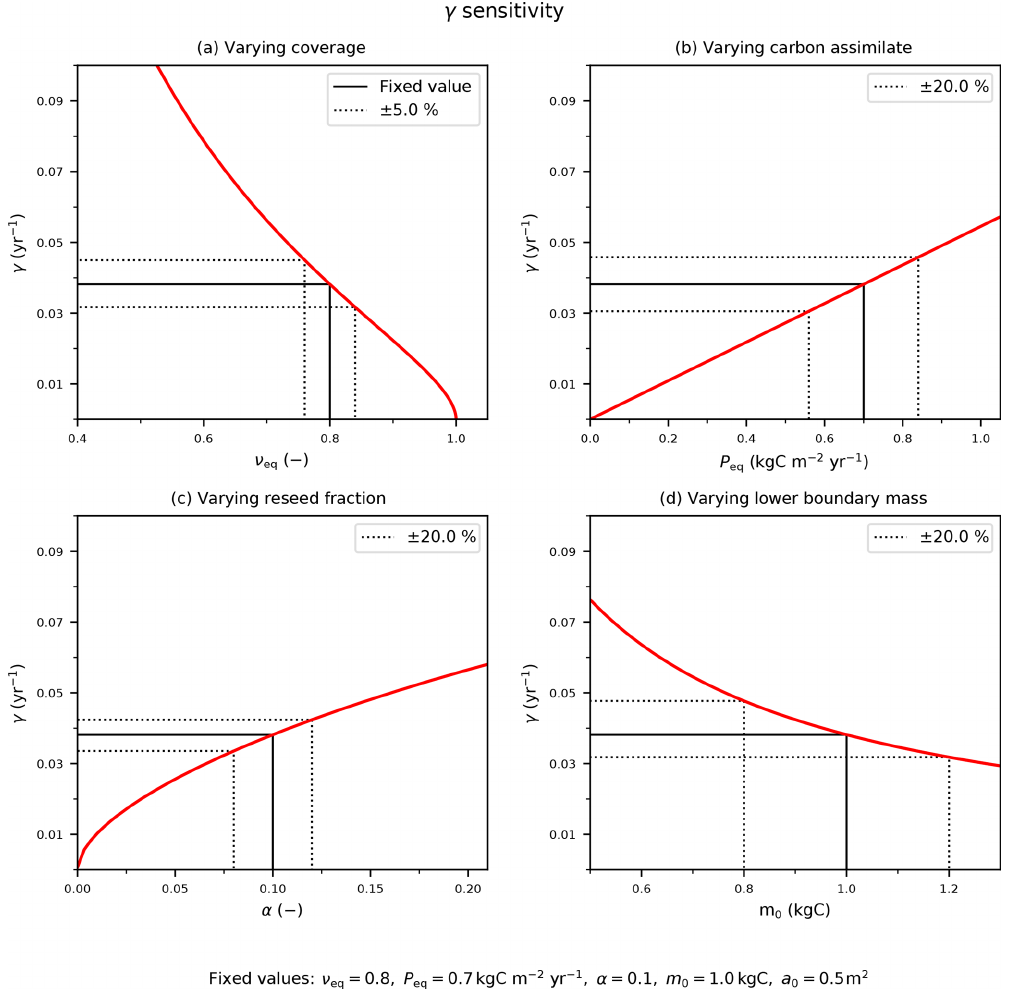
Figure C1. The sensitivity of the mortality rate to assumed input variables: (a) coverage, ν eq ; (b) P eq carbon assimilate rate; and model parameters (c) reseed fraction, α , and (d) boundary mass, m 0 . The solid black line indicates the fixed values with corresponding (b–d) ± 20% or (a) ± 5% variation (dotted black